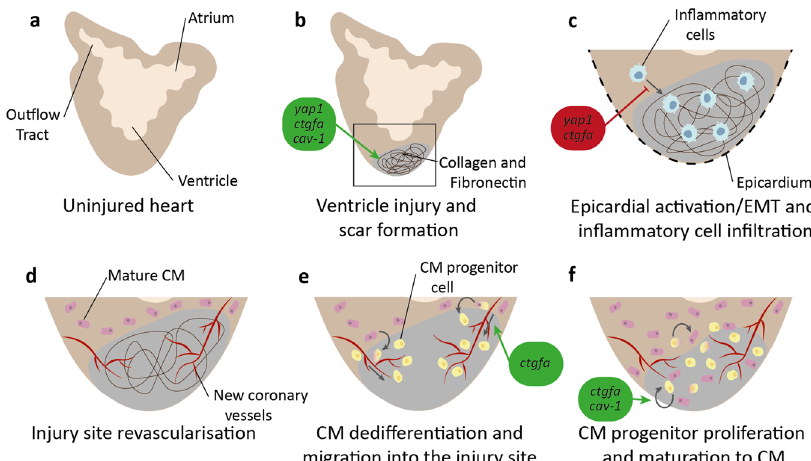
Fig. 3 Overview of zebra fi sh heart regeneration. a Structure of the uninjured zebra fi sh adult heart. b Injury at the ventricle apex induces collagen and fi bronectin deposition and scar formation. yap1, ctgfa , and cav-1 promote appropriate and transient scar formation. c Heart epicardium undergoes EMT and in fl ammatory cells (blue) in fi ltrate into the scar. yap1 and ctgfa inhibit in fl ammatory cell in fi ltration. d New coronary vessels form to revascularize the injury site. e Mature cardiomyocytes (CMs) (pink) dedifferentiate into progenitor cells (yellow) and migrate along the new coronary vessels into the injury site. ctgfa promotes CM migration. f CM progenitors proliferate to create a progenitor cell pool, which matures back to CMs to reform the heart muscle. ctgfa and cav-1 promote cell